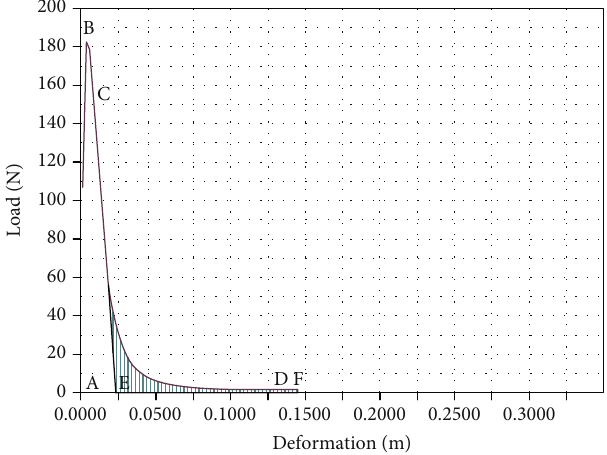
Figure 5: 3# tire rubber powder-modi fi ed asphalt viscosity test load-deformation diagram.